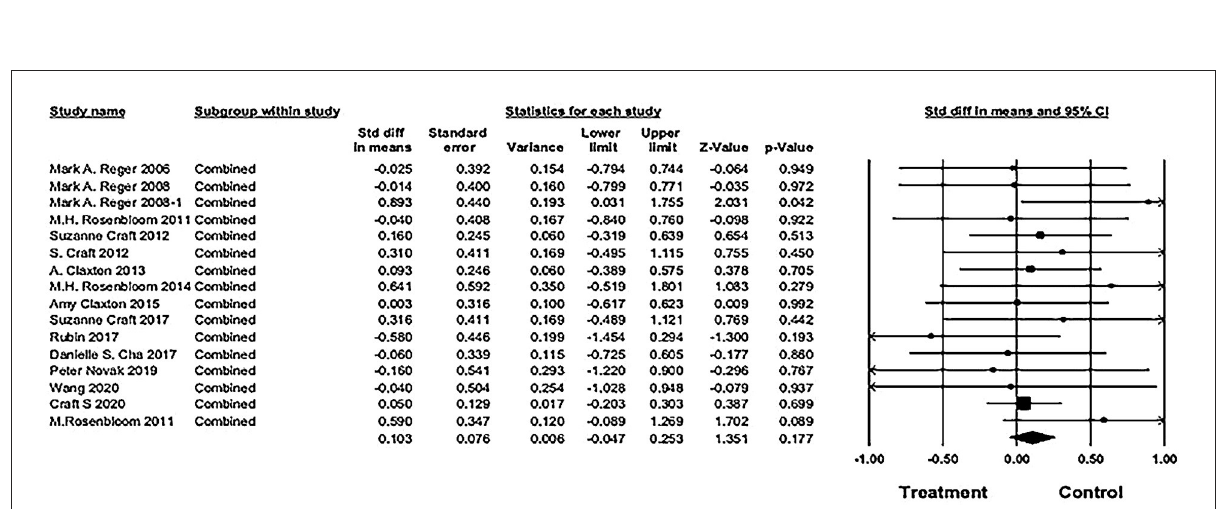
FIGURE5 Forest plot of pooled standard mean difference (SMD) for combined cognitive score. The pooled SMD was 0.103 [16 studies; 95% confidence interval (CI), − 0.05 to 0.25; P = 0.18), showing no significant difference between IN insulin and placebo groups (weights and heterogeneity test are from random-effects